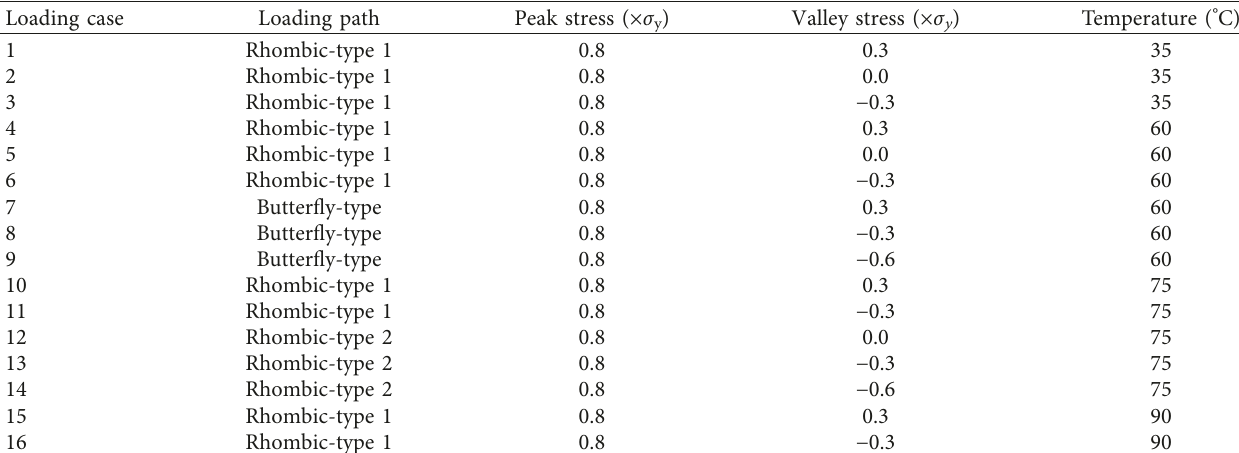
Figure 4: Diagram of nonproportional multiaxial stress-control loading path: (a) rhombic-type 1, (b) butterfly-type, and (c) rhombic-type 2. Table 1: Multiaxial stress-control cyclic loading